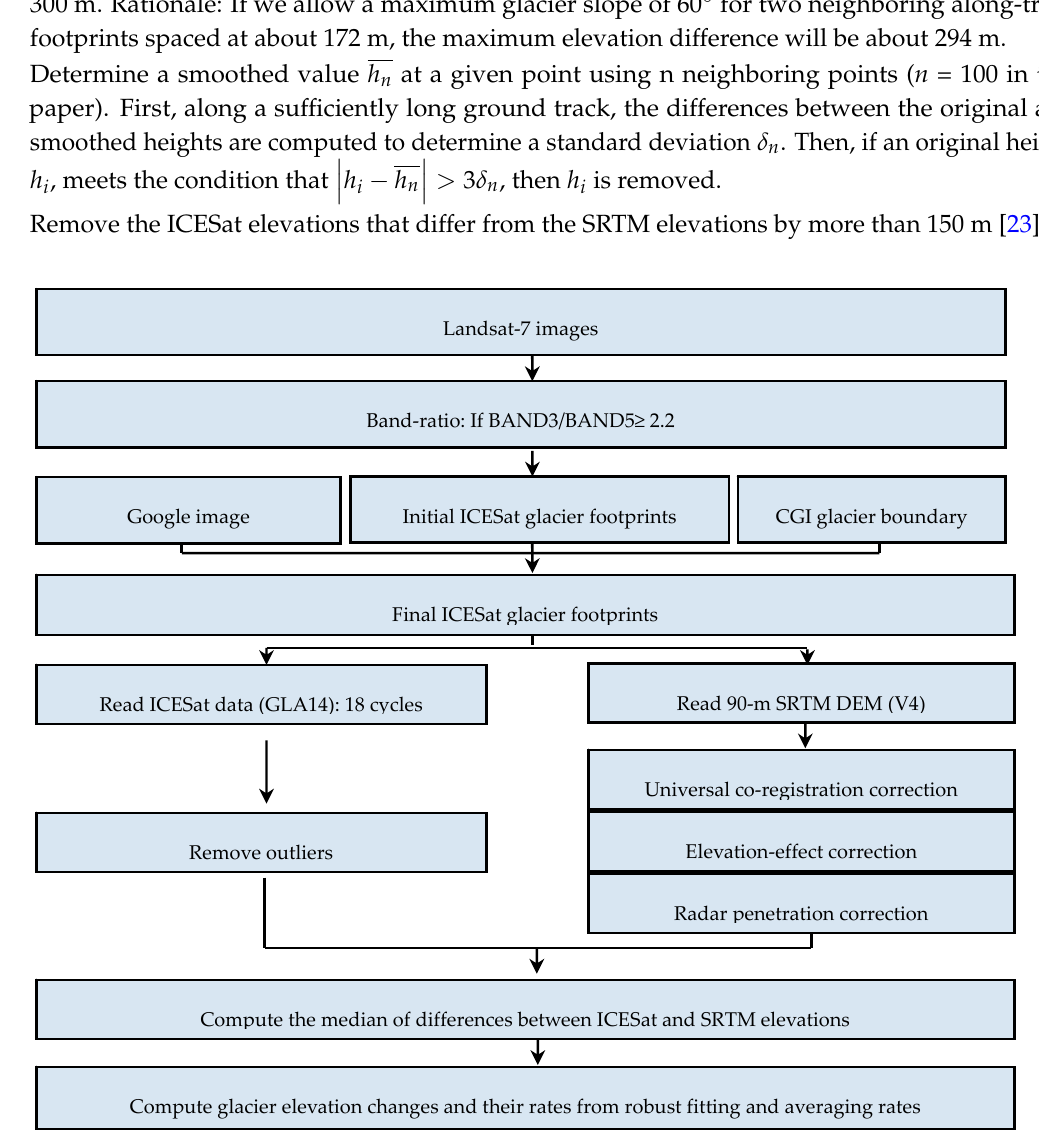
Figure 3. The flowchart for determining glacier elevation changes and their rates using ICESat measurements and the SRTM DEM.